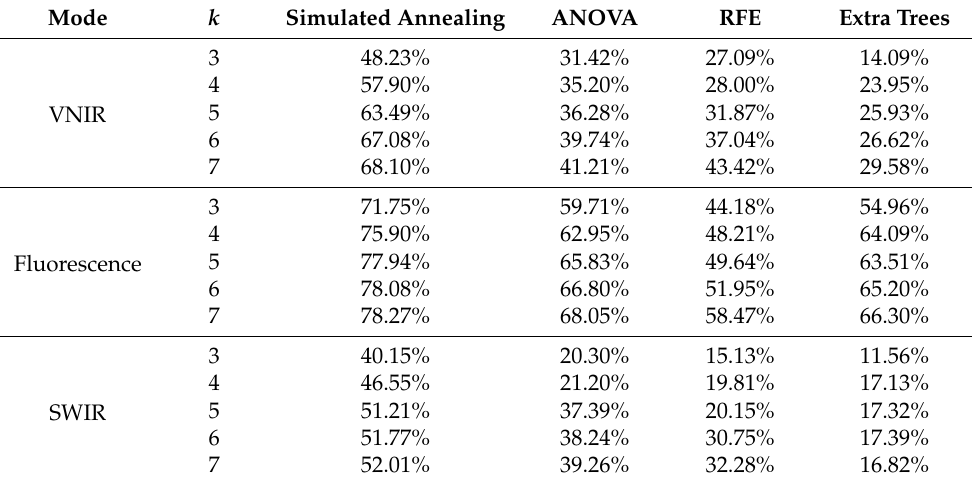
Table 2. Results of comparison between wavelength selection methods. Values represent 4-fold cross validation accuracies resulting from training the WKNN classifier with the selected wavelengths.